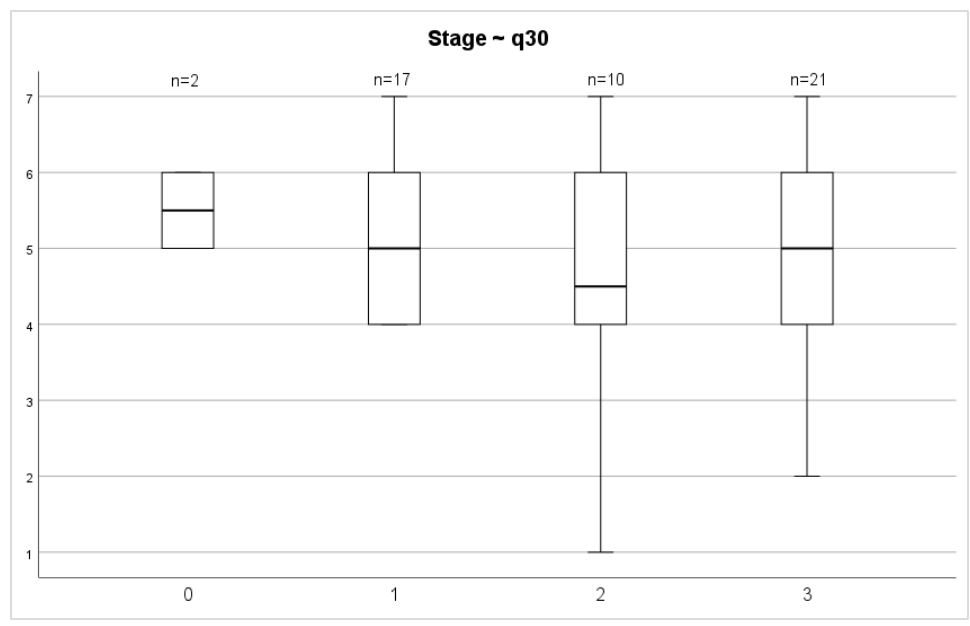
Figure 6. Stage and general health status.